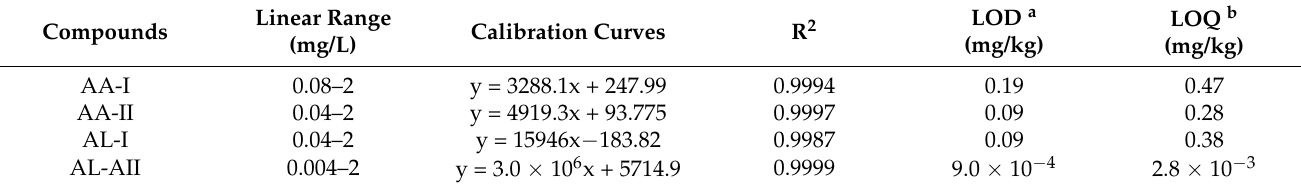
Table 3. Calibration curves, LODs (the limits of detection) and LOQs (the limits of quantification) of investigated